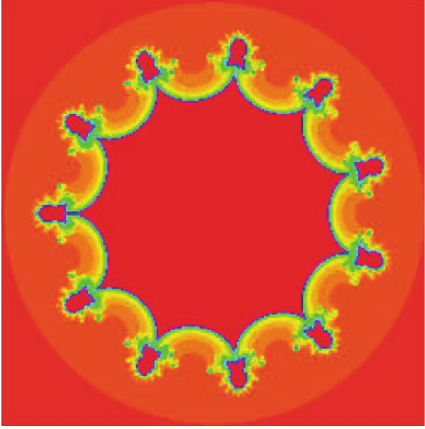
Figure 22: Relative superior multicorn for 𝑠 = 0.2 , 𝑠 󸀠 = 0.7 , and 𝑛 = 10 .